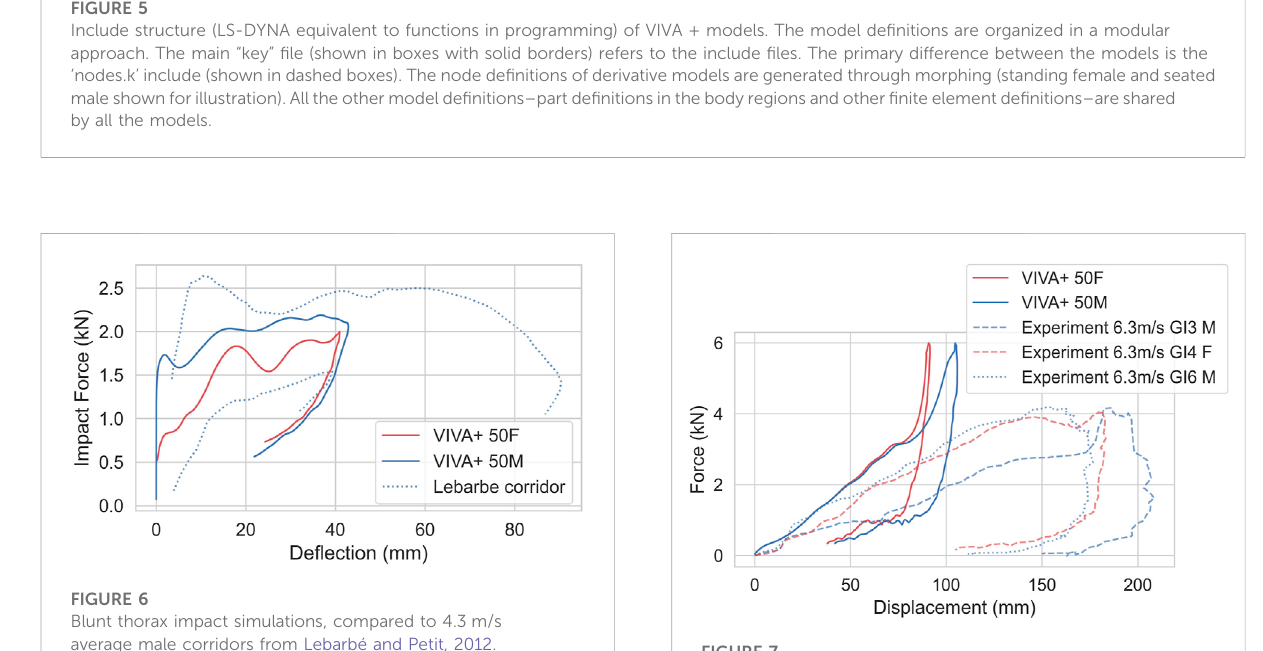
FIGURE 7 Barimpactsatmid-abdominalregion(alignedtoL3)at6.3 m/ s, compared to experiments from Hardy et al., 2001. Dashed/ dotted lines show experimental responses, red color represents females and blue represents males.